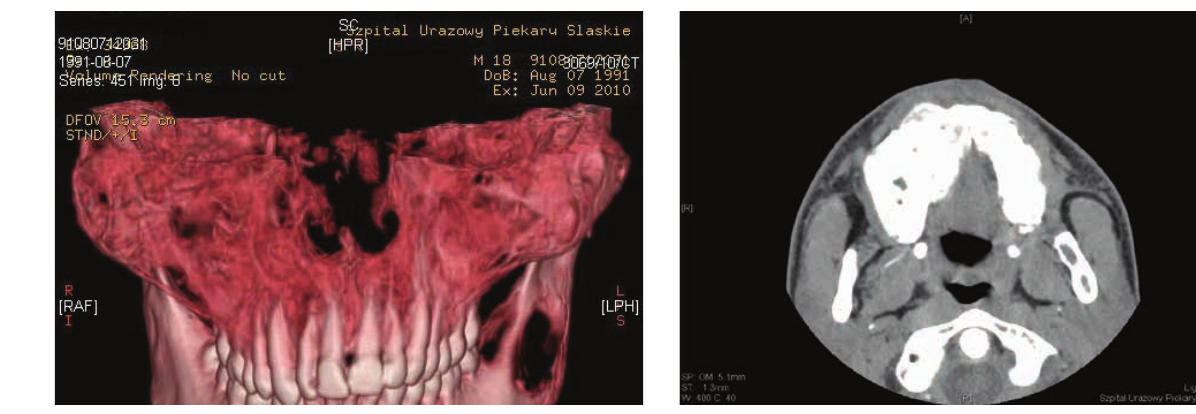
Figure 4a: Patient K. M, aged 19. CT scan. 3D reconstruction. Facial view.